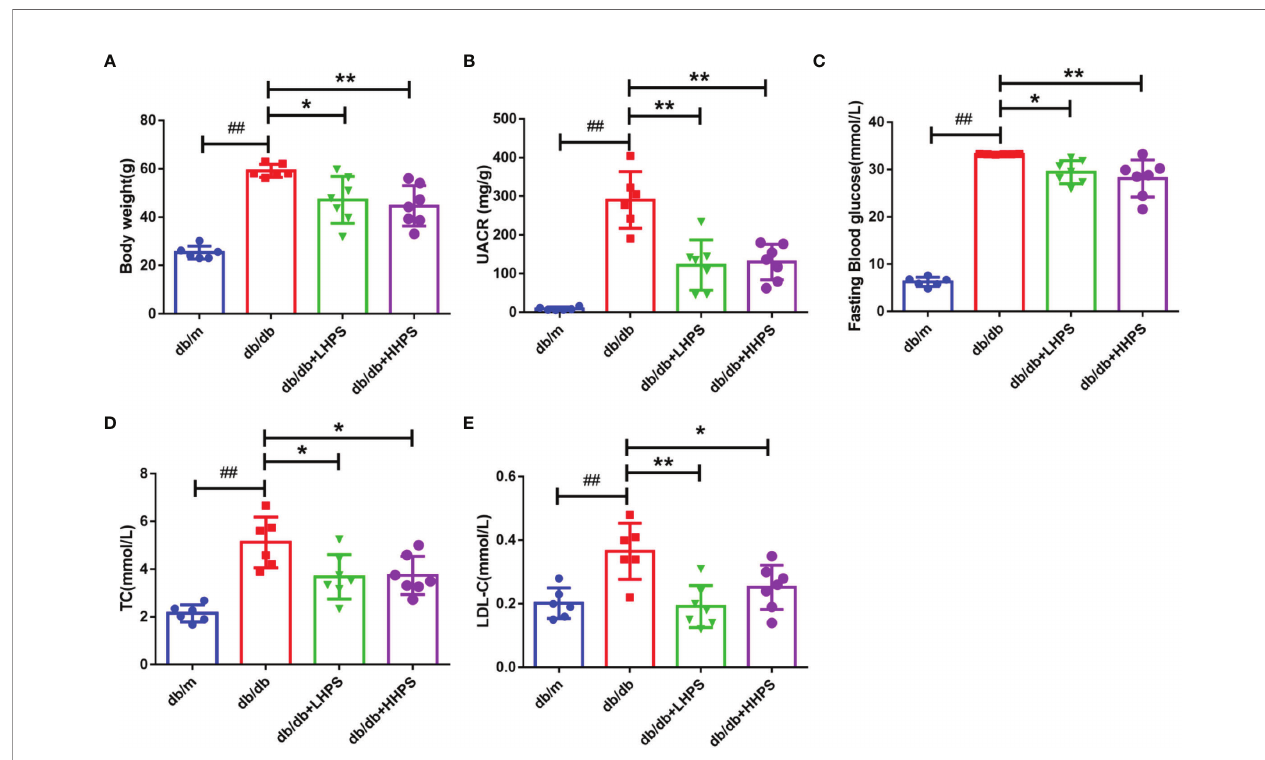
FIGURE 1 | Clinical and metabolic parameters in four groups of mice: db/m , db/db , db/db +LHPS, and db/db +HHPS mice. (A) Body weight (g), (B) Urine albumin- to-creatinine ratio (UACR) (mg/g), (C) Fasting blood glucose (FBG) (mmol/L), (D) Total cholesterol (TC) (mmol/L), and (E) Low density lipoprotein-cholesterol (LDL-C) (mmol/L) were measured after HPS treatment. db/m , non-diabetic normal control mice; db/db , DN mice treated with distilled water; db/db + LHPS or HHPS, db/db mice treated with 40 (LHPS) or 80 mg/kg/day (HHPS) of HPS, respectively. Data are presented as the mean ± SD (n=6-7, with individual donors shown as dots, ## P < 0.01 vs db/m ; * P < 0.05 and ** P < 0.01 vs db/db